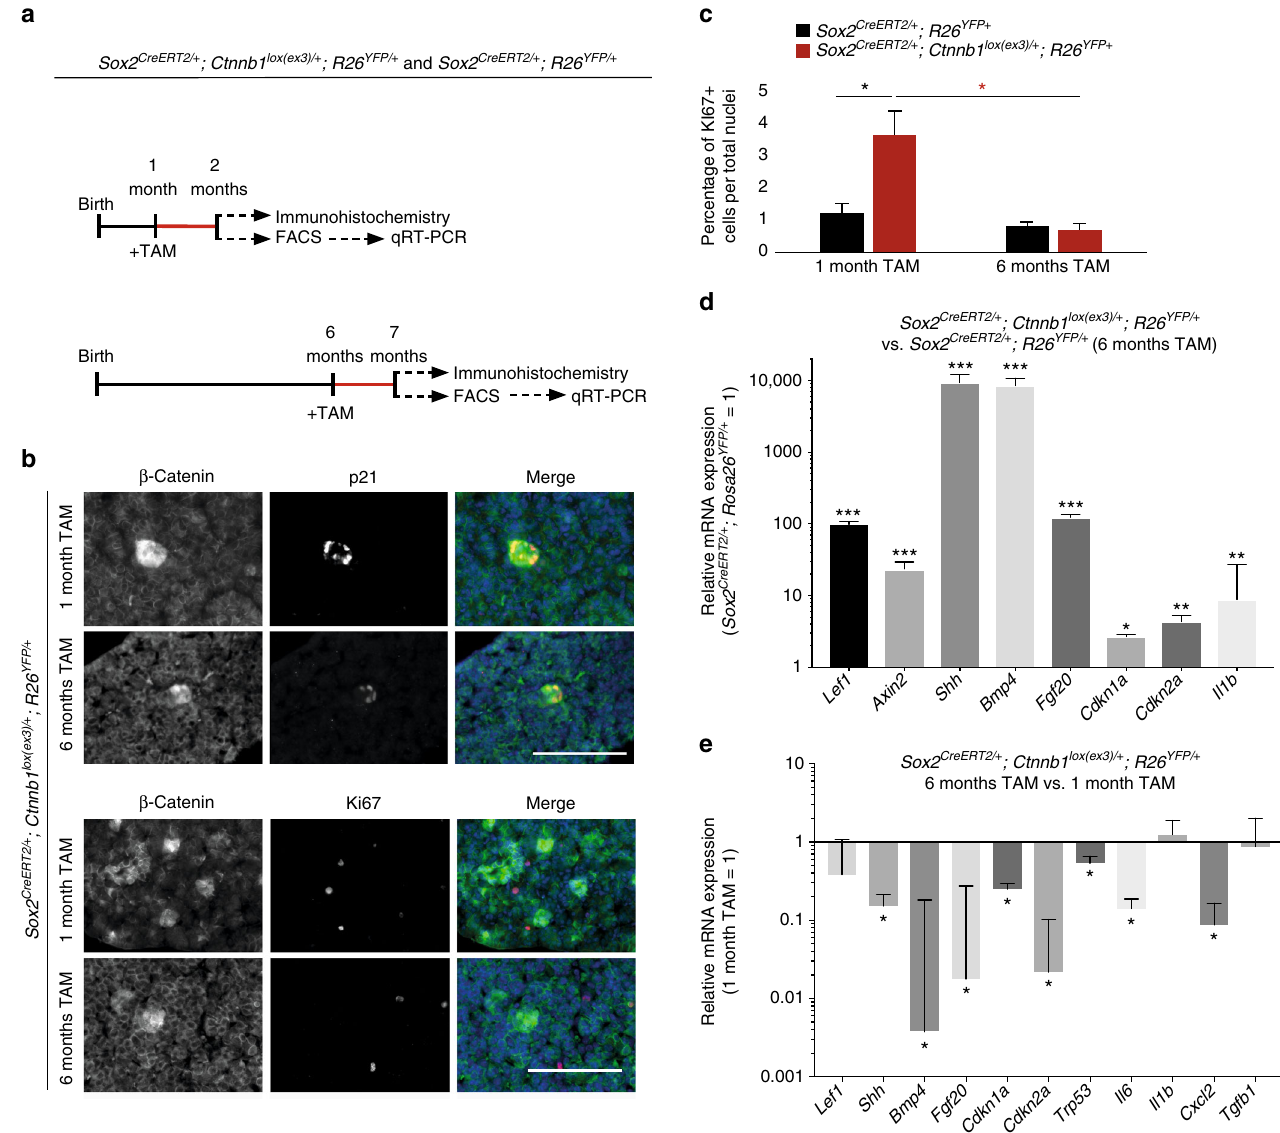
Fig. 6 Aged Sox2+ stem cells generate β -catenin-accumulating cell clusters with reduced senescence and SASP responses. a Schematic diagram of the experimental designs. Sox2 CreERT2/ + ;Ctnnb1 lox(ex3)/ + ;R26 YFP/ + and Sox2 CreERT2/ + ;R26 YFP/ + mice were tamoxifen induced at either 1 or 6 month of age and the anterior pituitary collected 4 weeks post induction and processed for histological and molecular analysis of YFP+ cells isolated by FACS ( n = 8 mice per group). b Double immunostaining on histological sections of Sox2 CreERT2/ + ; Ctnnb1 lox(ex3)/ + ; R26 YFP/ + pituitaries revealing the presence of β -catenin- accumulating cell clusters positive for p21, but not for Ki67. Scale bar: 100 µ m. c Quantitative analysis showing a signi fi cant higher Ki67 proliferation index in non-cluster cells in Sox2 CreERT2/ + ;Ctnnb1 lox(ex3)/ + ;R26 YFP/ + tumoural relative to Sox2 CreERT2/ + ;R26 YFP/ + control pituitaries in tamoxifen-induced mice at 1 month (black asterisk), but not at 6 months. Increased proliferation index is also observed in non-cluster cells in Sox2 CreERT2/ + ;Ctnnb1 lox(ex3)/ + ;R26 YFP/ + pituitaries of mice induced at 1 month relative to those induced at 6 months (red asterisk). d qRT-PCR analysis showing the upregulation of the WNT pathway target genes Axin2 and Lef1 , as well as of several senescence and SASP factors in the Sox2 CreERT2/ + ;Ctnnb1 lox(ex3)/ + ;R26 YFP/ + mutant pituitaries relative to the Sox2 CreERT2/ + ; R26 YFP/ + controls. e qRT analysis showing the relative expression of several senescence and SASP factors in Sox2 CreERT2/ + ; Ctnnb1 lox(ex3)/ + ;R26 YFP/ + mice tamoxifen induced at either 1 (young) or 6 (older) months of age. The expression of several senescent and SASP factors is signi fi cantly reduced in the older compared with the young mice. Bars in c , d and e represent the mean, and error bars represent standard error of the mean (SEM) of three biological replicates. * p < 0.05, ** p < 0.01, *** p < 0.001, Student ’ s t